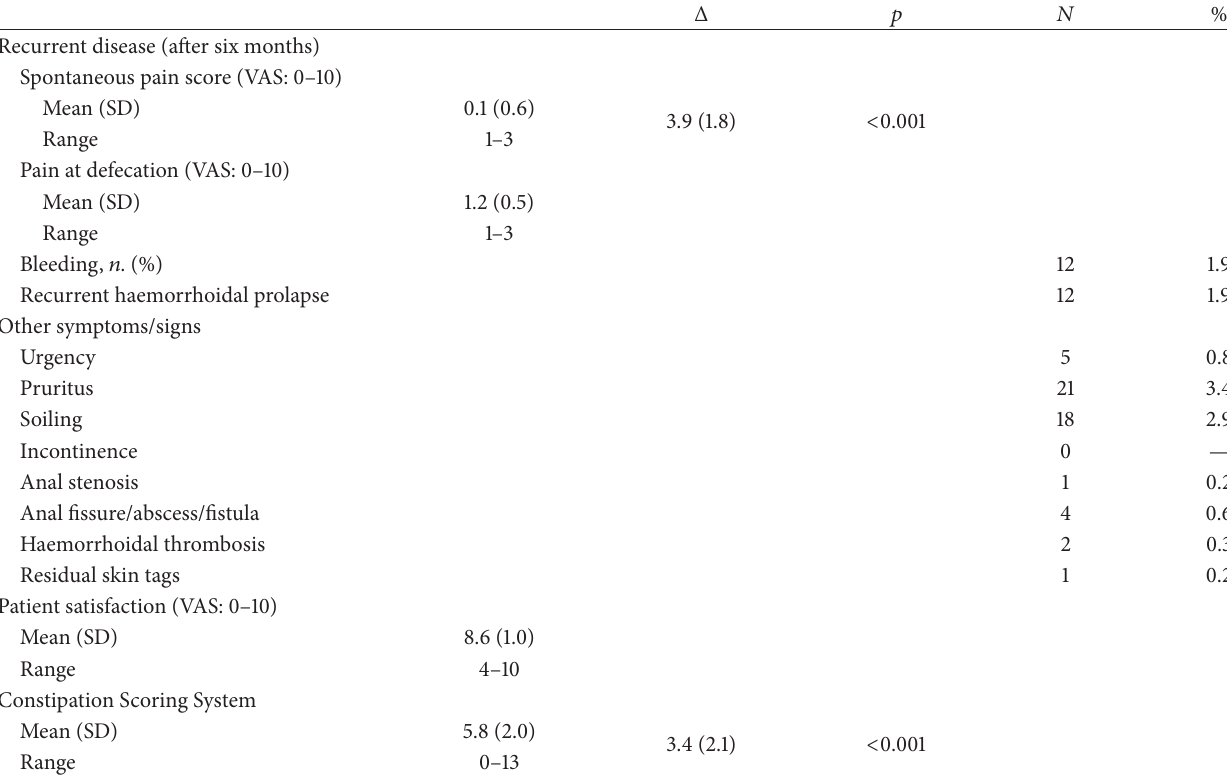
Table 5: Follow-up at 12 months in 581 patients.